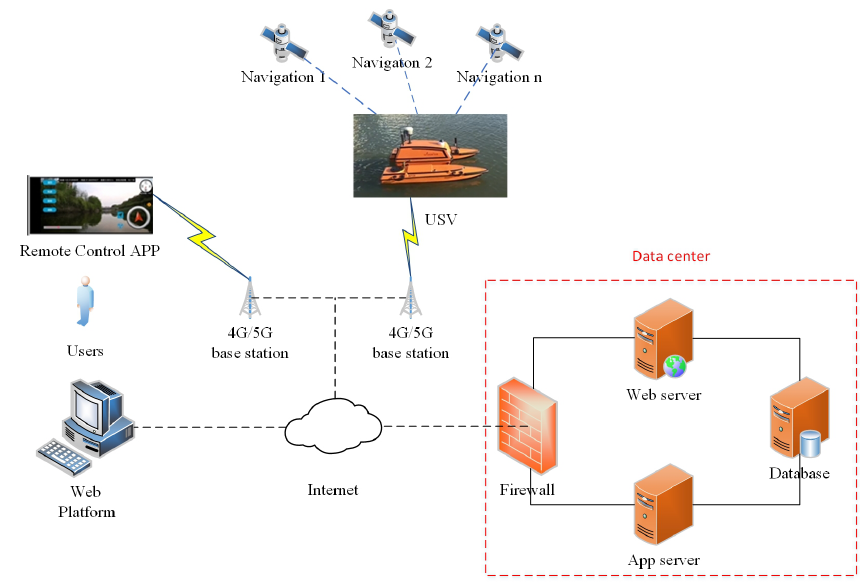
Figure 21. Communication architecture of